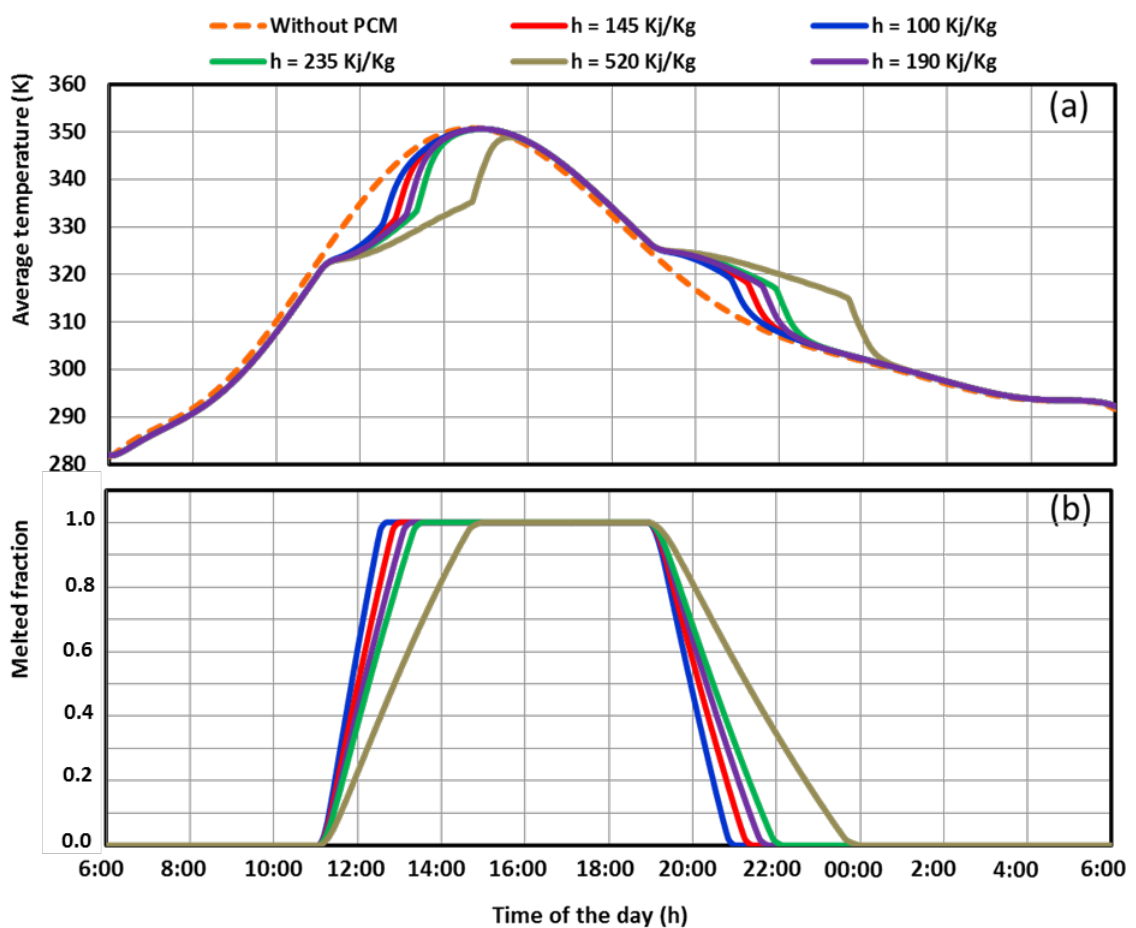
Figure 10. The effect of the PCM enthalpy on: ( a ) the average water temperature; and ( b ) the average PCM melted fraction.